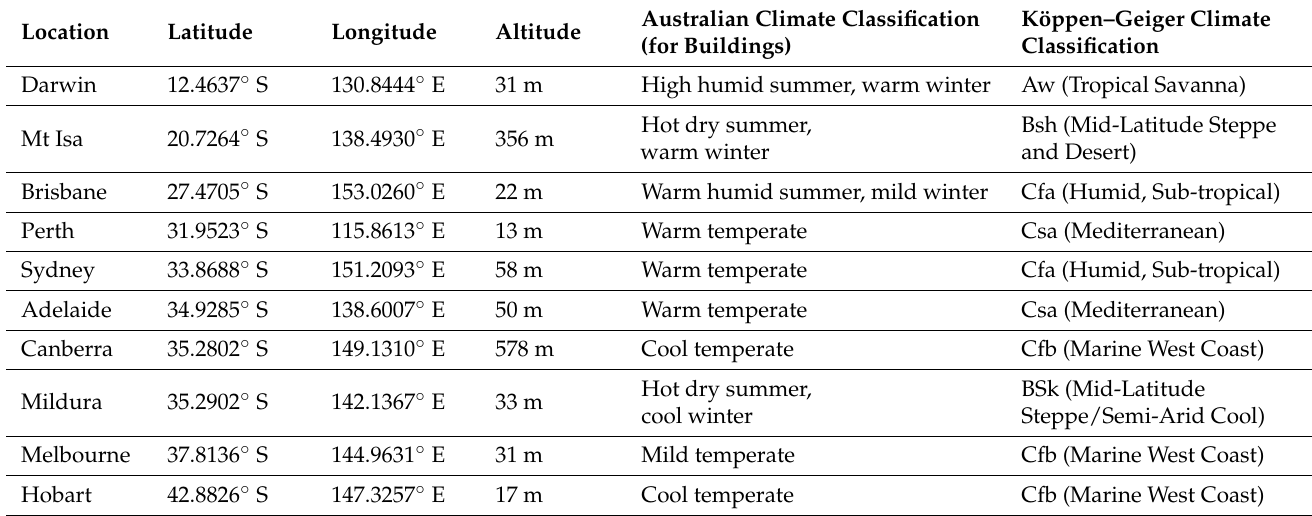
Figure 2. Australia’s eight broad climate zones for building regulations (Source: NCC). Table 5. Locations and